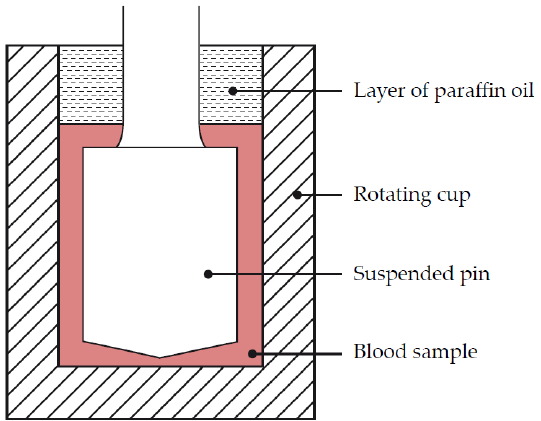
Figure 2. Dr. Hartert’s cup and pin mechanism. Schematic drawing representing parts of the thromboelastograph that were in direct contact with the blood sample. The rotating cup was approximately 8 x 12 mm and made from stainless steel, the surface of which prevented detachment of the blood clot during cup rotation. The blood sample was covered by a layer of paraffin oil to prevent evaporation of the sample. Reproduced with permission from [4] .